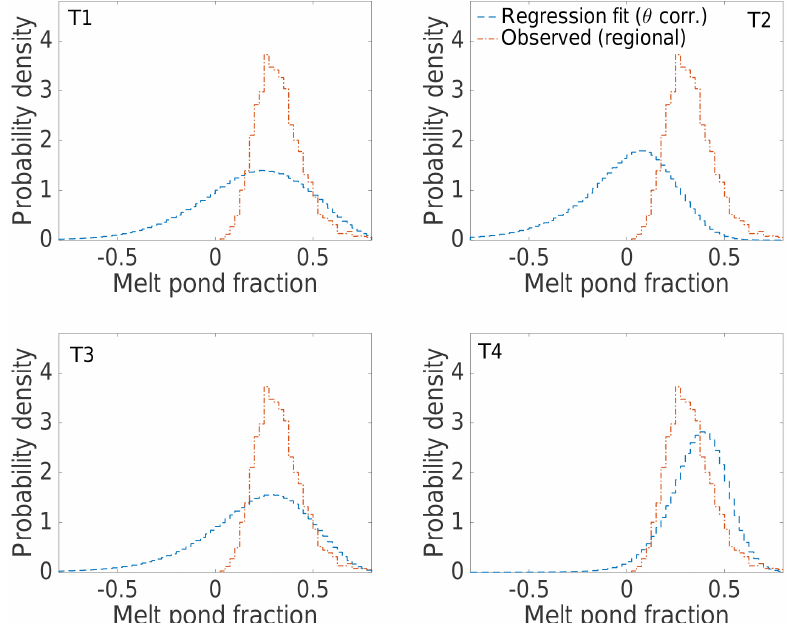
Figure 11. Probability density distributions of f MP for the four investigated scenes (T1–T4). Curves represent distributions produced from the σ 0 -based regression with a 51 × 51 pixel window, and the observed distribution retrieved from all five helicopter VV